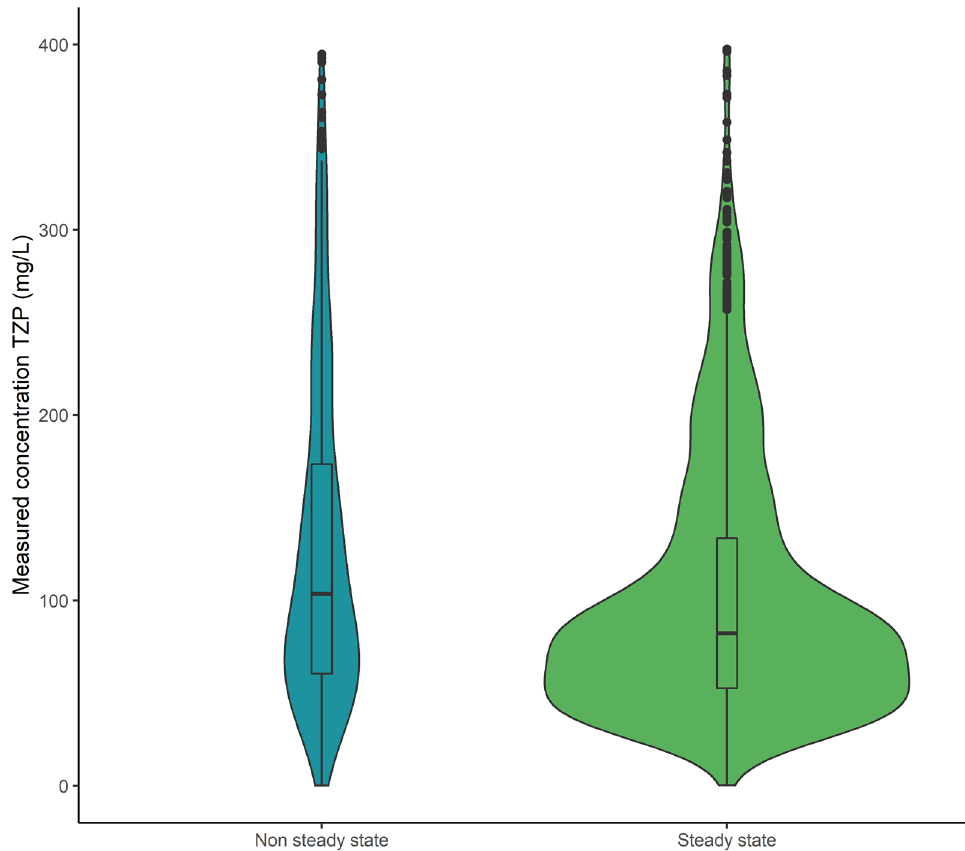
Fig. 1 Violin plot of free TZP concentrations according to sample state ( p <